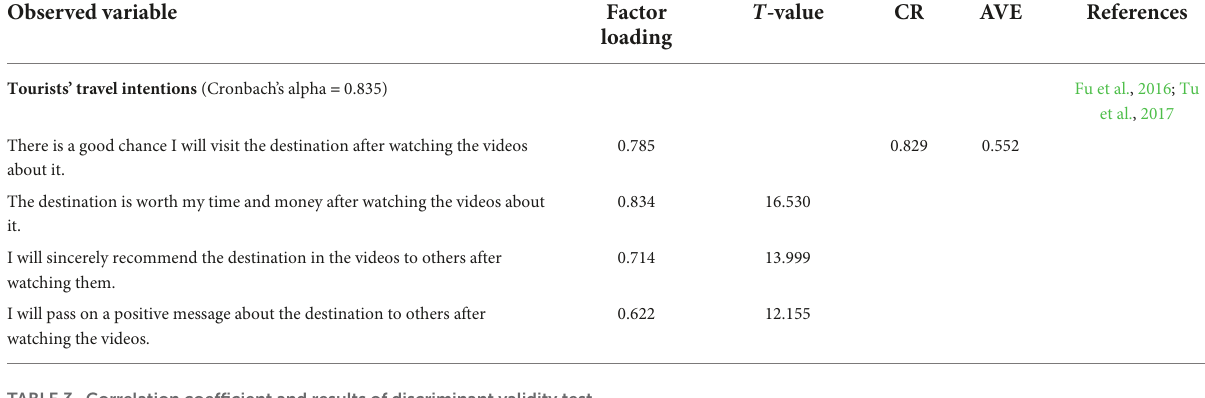
TABLE 3 Correlation coefficient and results of discriminant validity test.